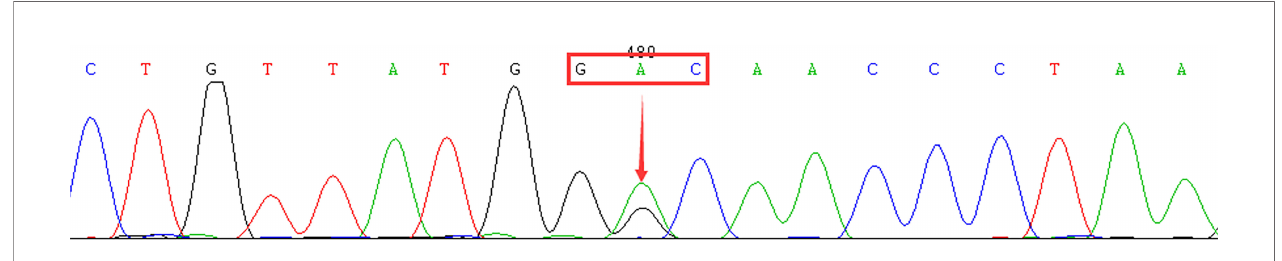
FIGURE 3 | Gene mutation in